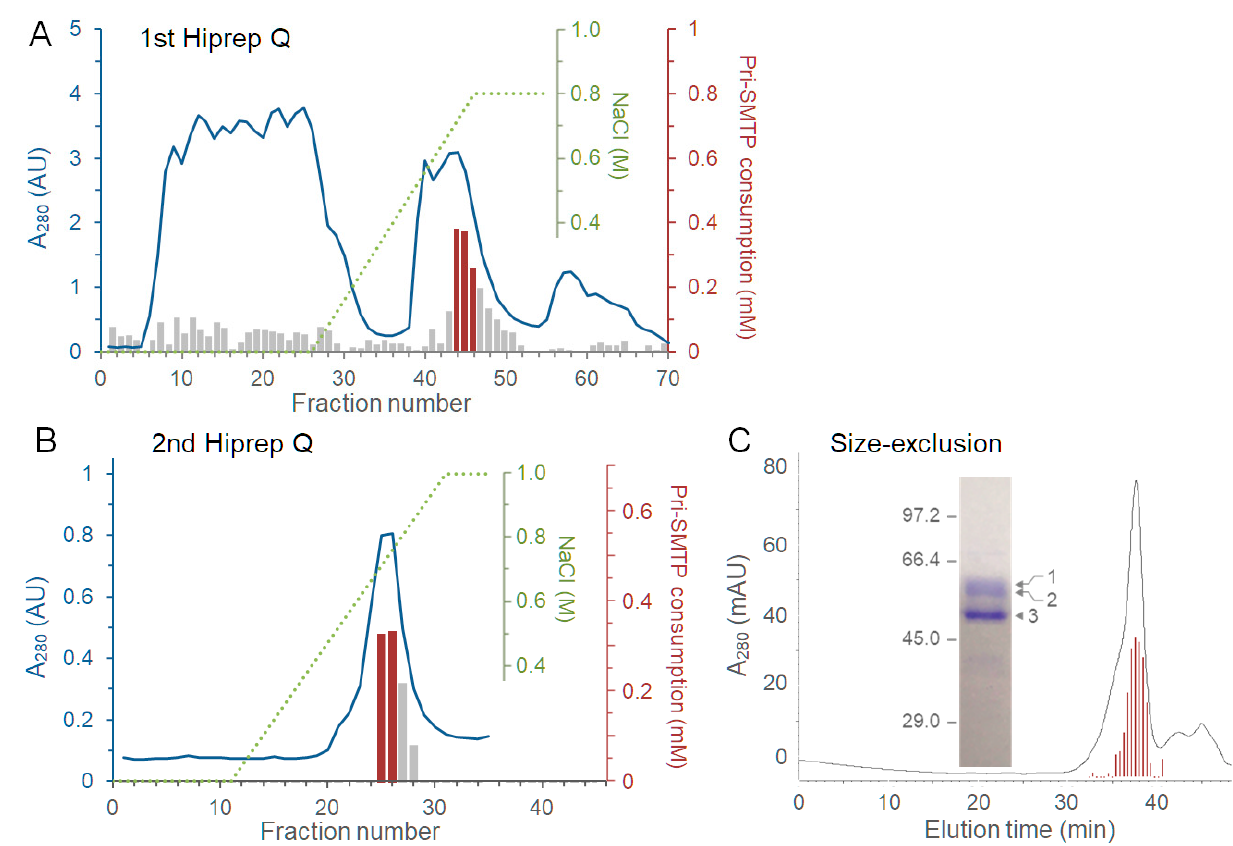
Figure 5. Purification of pri-SMTP oxidase. The cytosol fraction of S. microspora homogenate was subjected to ammonium sulfate fractionation. The precipitates at 75% saturation were dialyzed and fractionated via anion-exchange chromatography on Hiprep Q ( A ). The fractions containing pri-SMTP oxidase activity (red bars) were further fractionated via repeated chromatography on Hiprep Q ( B ). The peak fractions (red bars) were analyzed using gel permeation chromatography ( C ). The SDS-PAGE analysis of the peak fraction demonstrated one major band at 50.7 kDa, and two minor bands at 57.0 and 59.5 kDa (inset in panel ( C )). The major protein was assigned to a putative oxidase using the peptide mass fingerprinting method (see Figure S3, Tables S4 and S5 for details), whereas the minor proteins at 57.0 and 59.5 kDa were allocated to a putative α / β -hydrolase and a putative zinc peptidase (orthologous to S40285_05629 and S40285_05629 proteins in S. chlorohalonata IBT 40285, respectively). In the chromatograms, solid lines, dotted lines, and bars represent the absorption at 280 nm, NaCl concentration, and pri-SMTP oxidase activity, respectively.